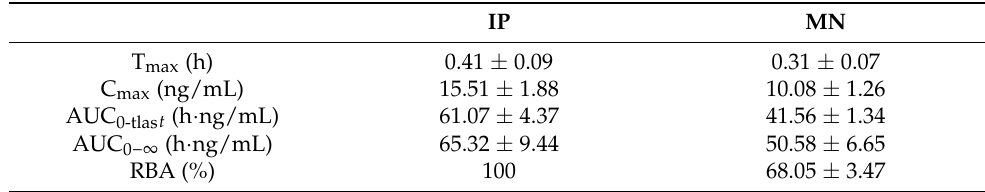
Table 2. Pharmacokinetic parameters of rats in the two groups after drug